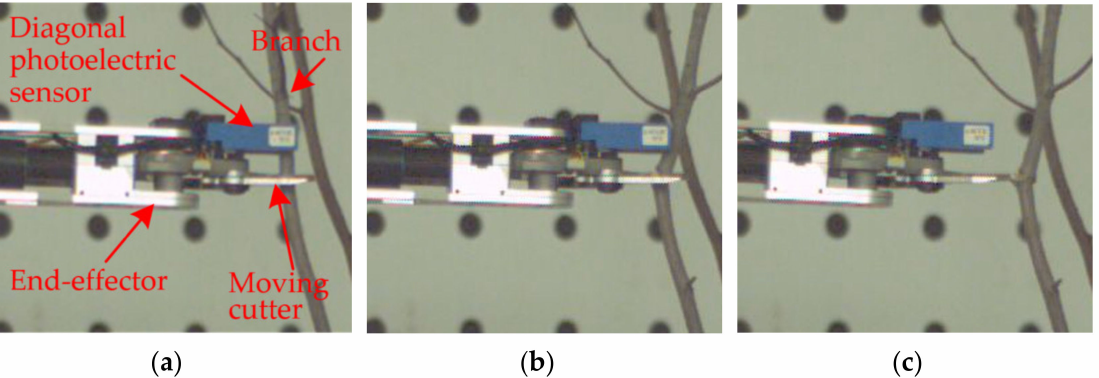
Figure 15. The whole process of failed pruning of the manipulator. ( a ) The start of the pruning process; ( b ) during the pruning process; and ( c ) the branch has not been pruned.